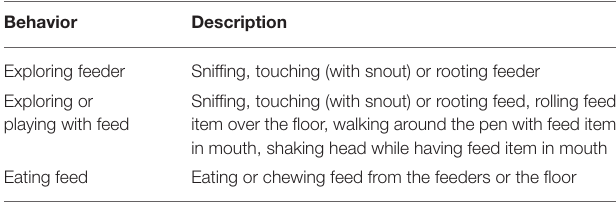
TABLE 1 | Ethogram of feed-directed behavior observed in the home pen pre-weaning. Behavior